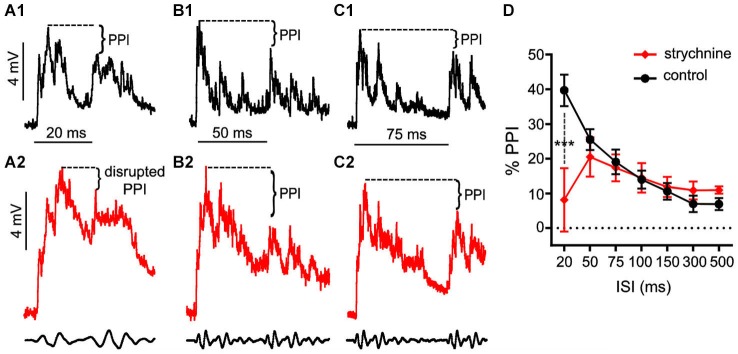
Glycinergic inhibition contributes to the earliest components of PPI. (A–C). Sample intracellular recordings from the Mauthner-cell (M-cell) soma in response to paired (prepulse/pulse) sound pips at ISIs of 20 ms (A1,A2), 50 ms (B1,B2), and 75 ms (C1,C2) in control (black) and after application of the GlyR antagonist strychnine (red). Bottom traces show sound stimuli (200 Hz single-cycle “pips” at 80 dB re: 20 μPa). Dashed lines and brackets indicate how PPI was quantified by comparing peak depolarization between the two evoked post-synaptic potentials (PSPs). (D) Plots of the mean % PPI effect (± SEM, N = 9) across the full range of ISIs tested in control (black line) and strychnine (red line) conditions; asterisks indicate an ISI-specific reduction in PPI at the 20 ms ISI (see text).